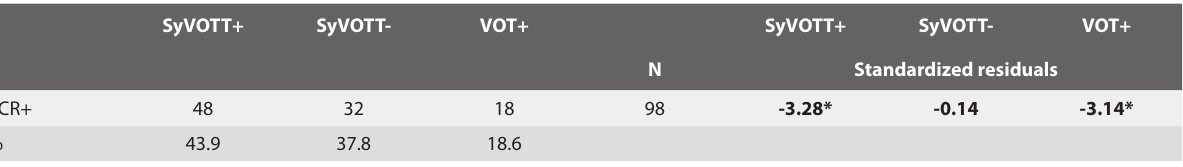
Table 5. General symptoms and chemosensory dysfunction in SARS-CoV-2 infection.